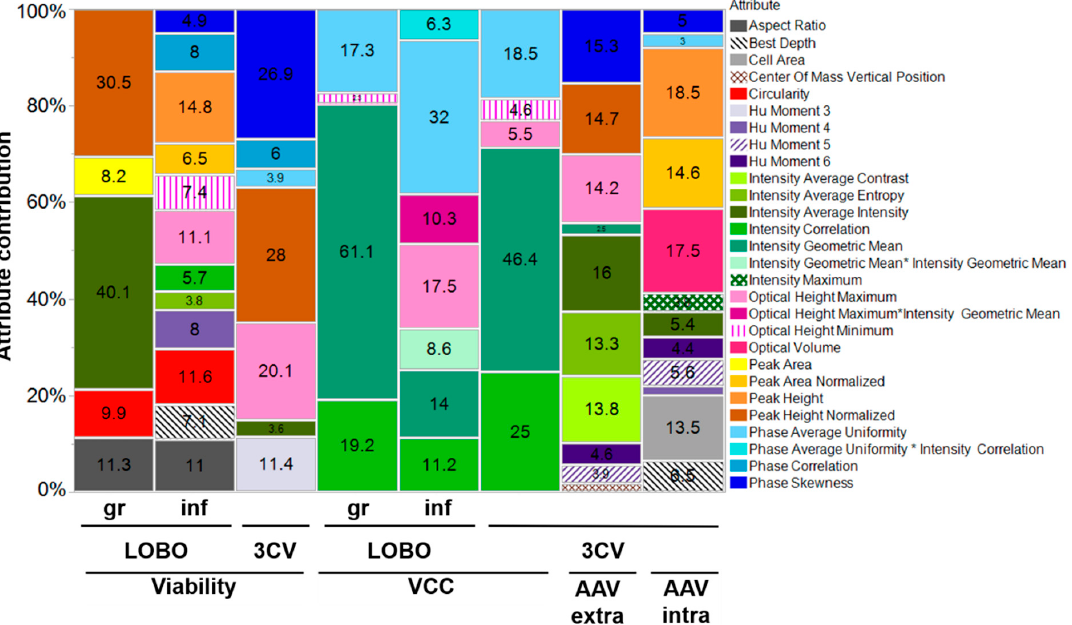
Figure 5. Relative contribution of each parameter to the final models. For the leave one batch out (LOBO) models, the batch used for model calibration is indicated (gr—growth; inf—infected). For the 3CV models, the coefficients presented are related to the model using both batches. Relative importance was calculated using the logworth for each parameter (Table S1).